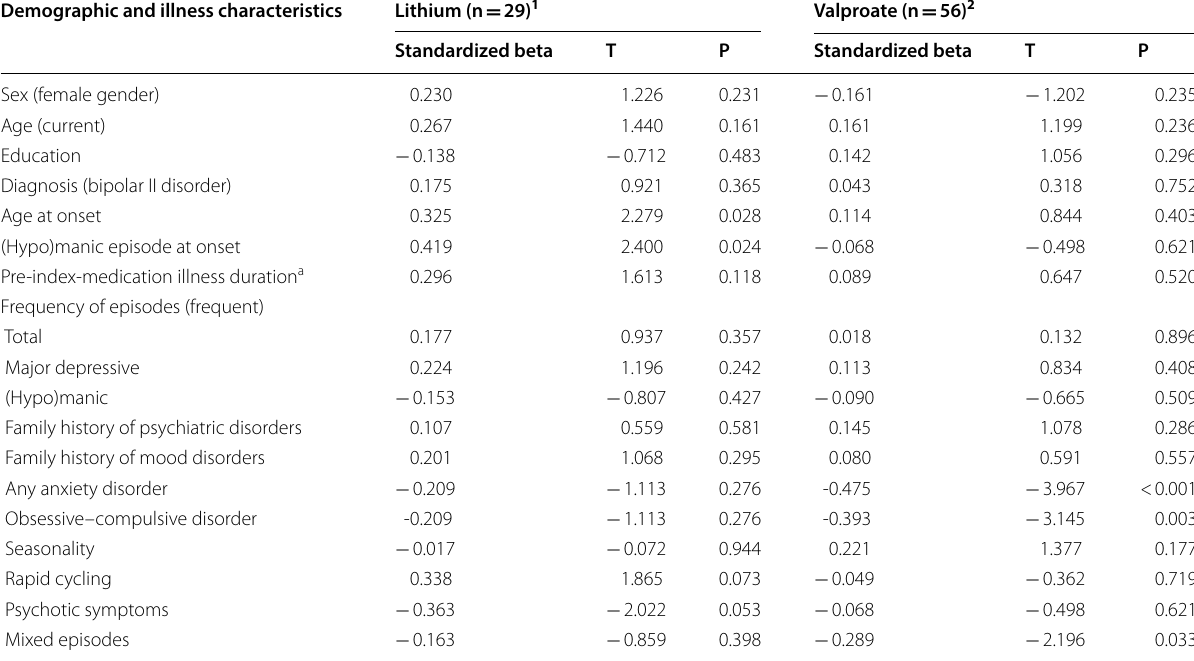
a Duration from illness onset to start of the index medication 1 Lithium monotherapy group 2 Valproate monotherapy group